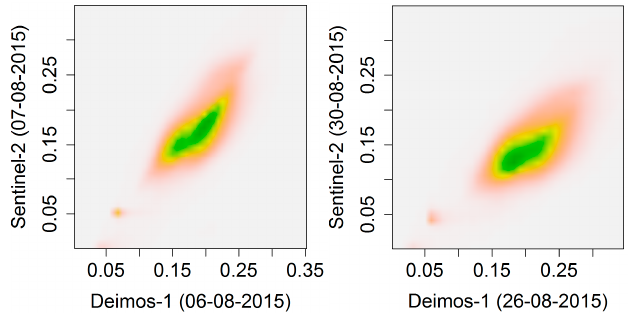
Figure 11. Scatterplots between Sentinel-2 and Deimos-1 broadband HDRF for two different dates.